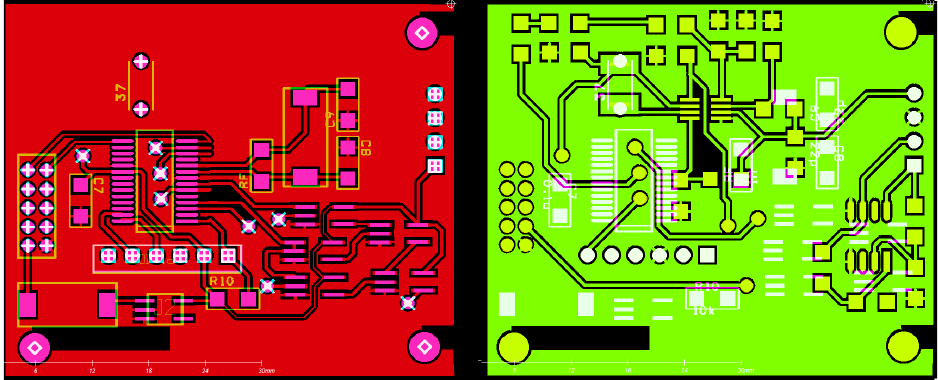
Figure 4. PCB layout of the NOPELED controller. Top and bottom layers of the control